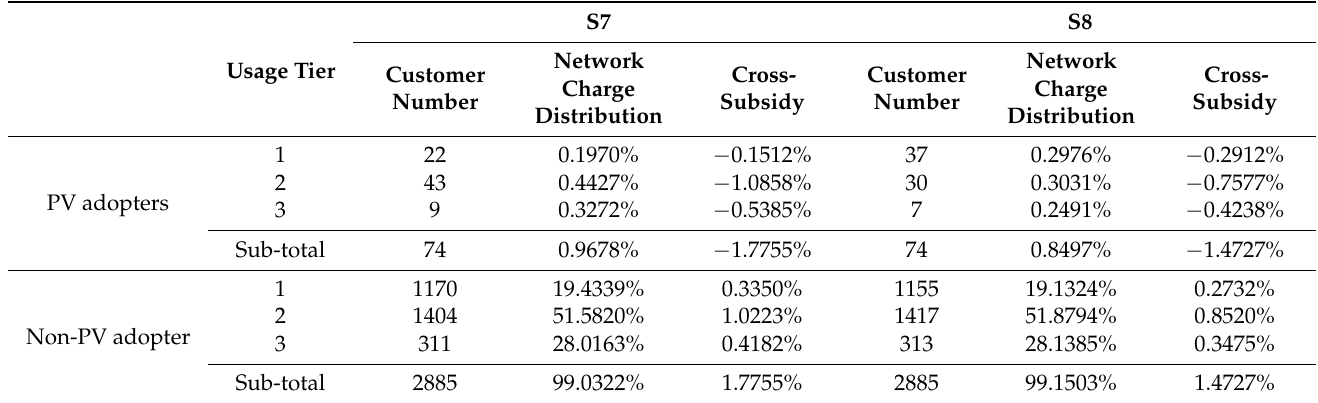
Table 8. Network charge distribution and cross-subsidy by usage tiers under increases in PV adoption level in usage tier